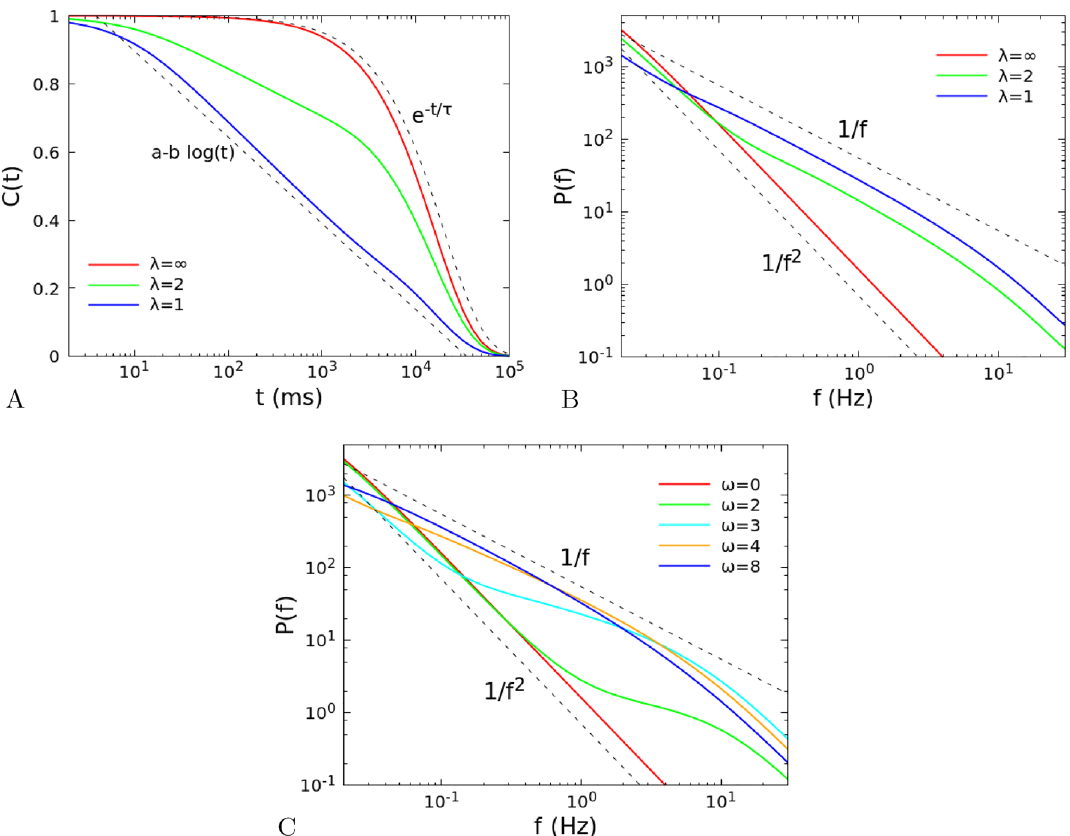
Figure 3. ( A ) Autocorrelation and ( B ) power spectrum of the single site firing rate in a two-dimensional L L model, in the linear approximation (number of neurons N ), as a function of the range (cid:31) of the × → ∞ 8 , and (cid:31) between 1 and 13.8 , 0.1 , h 100 , 10 w s ,0 w 0,0 interactions. We set L . Note that in the limit − ˜ = ˜ = = = ∞ (cid:31) the system is no longer 2D but fully-connected. The exponent β of the power-law decay of the power = ∞ 1 for the 2D model ( (cid:31) f − β is β L ) in agreement with the analytical predictions in section spectrum P ( f ) ∼ = ≪ 2 in the fully-connected case ( (cid:31) "Methods", while β ). ( C ) Power spectrum for connections decaying as a = ∞ = 0 , while β 2 for ω 1 for w s ,0 , w 0,0 and h of panels A and B. In this case β power law r − ω , with the same L , ˜ ˜ = = = 4 ω ≥